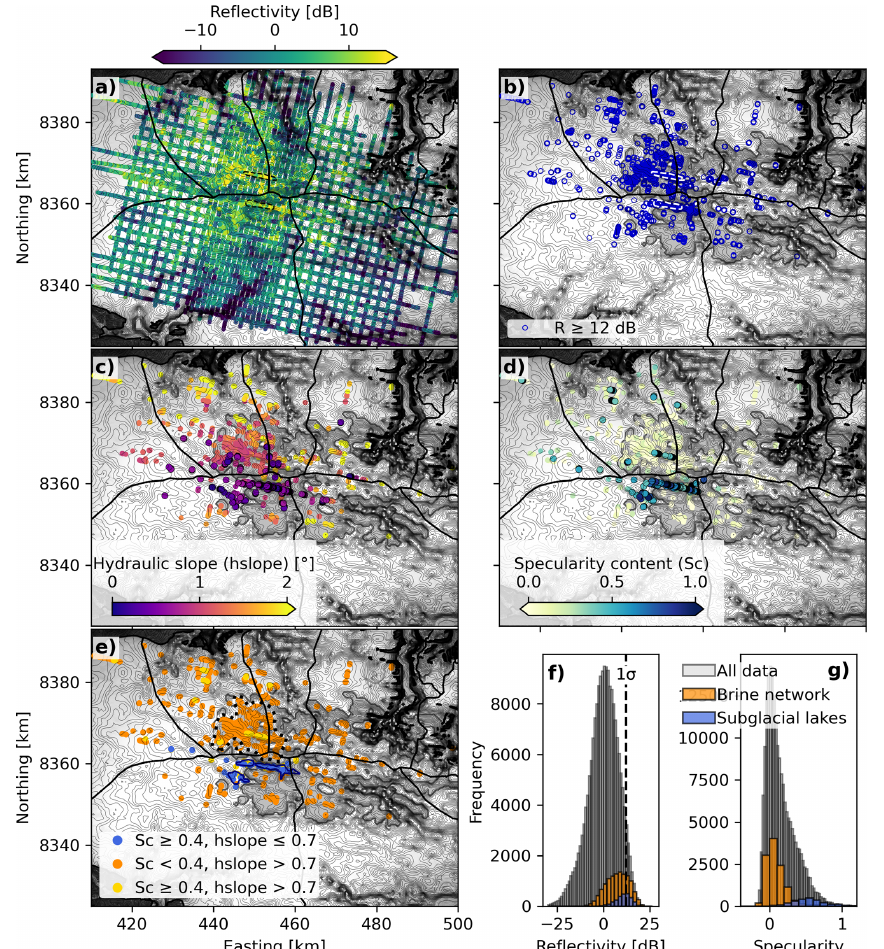
Figure 4. Radiometric characteristics and hydraulic slope for derivation of subglacial hydrological conditions. (a) Landsat image (with 25m bed contour interval) overlain with the basal reflectivity R . Black dotted outlines mark the location of the previously inferred subglacial lakes (Rutishauser et al., 2018). (b) Locations where R anomaly exceeds 12dB, indicating the presence of subglacial water. (c, d) R ≥ 12dB, color coded with the hydraulic slope (hslope) and specularity content (Sc). Dots with black outlines show regions with hslope ≤ 0 . 7 ◦ and Sc ≥ 0 . 4, respectively. (e) Combination of R , hslope, and Sc that (i) is typical for subglacial lakes (blue); (ii) may indicate distributed, shallow water/saturated sediments (orange) and possibly represent areas part of a brine network (black-white dotted outline); and (iii) indicates either wet or dry but highly specular (smooth) bedrock (yellow). Gray shaded area in panels (b) – (e) represents projected outcrops of the evaporite unit (Ocb). (f, g) Distribution of R and Sc over all measured data points, the interpreted brine network, and the newly defined lake